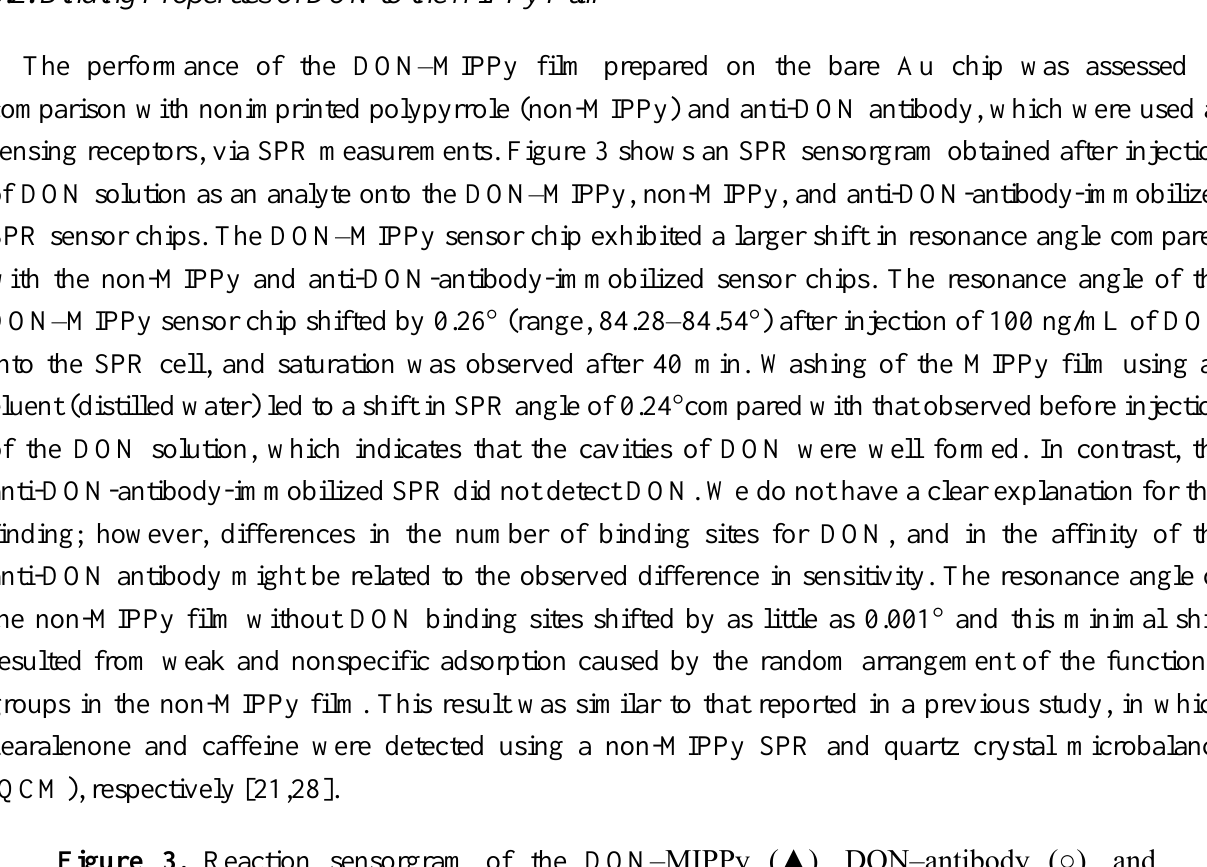
Figure 3. Reaction sensorgram of the DON–MIPPy (▲), DON–antibody (○), and non-MIPPy (■) films (used as receptors) formed on SPR bare Au chips using the DON solution (100 ng/mL). The SPR angle shift represents the difference between the angle after injection of the DON solution and the angle of the running